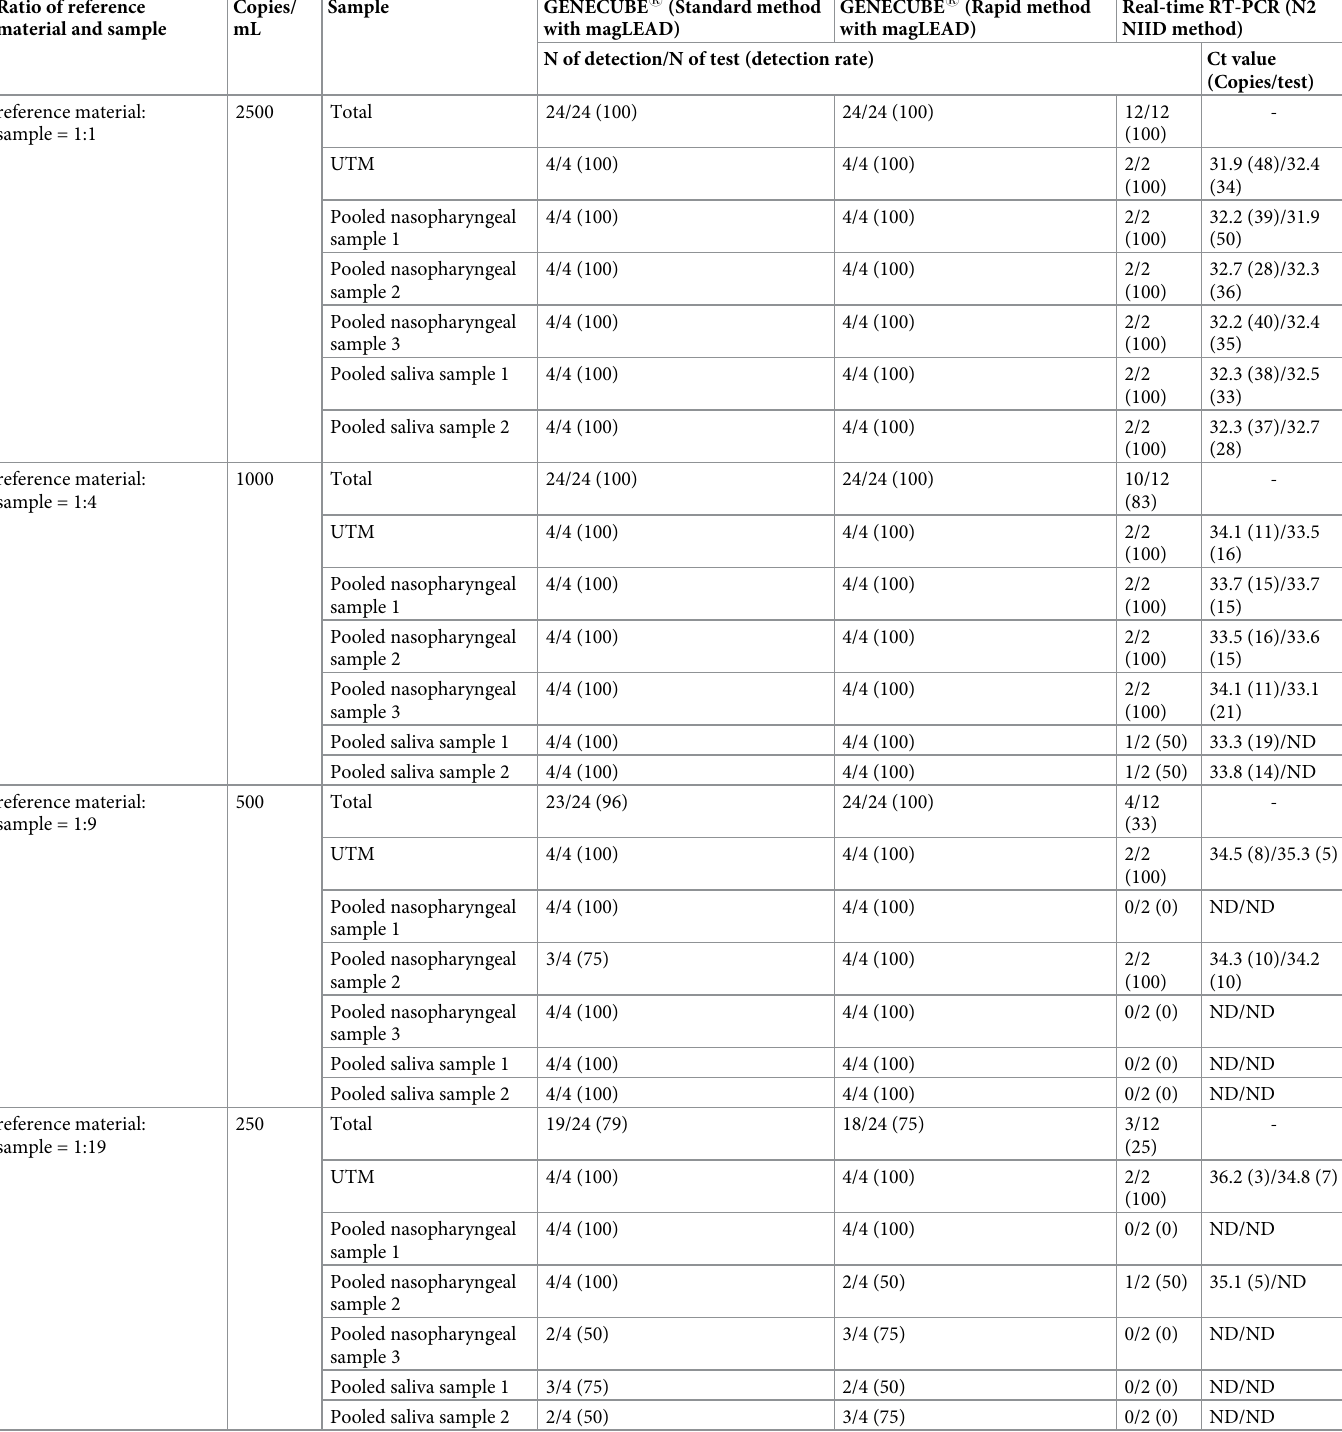
Table 2. Detailed results of the estimated LOD test for three SARS-CoV-2 detection